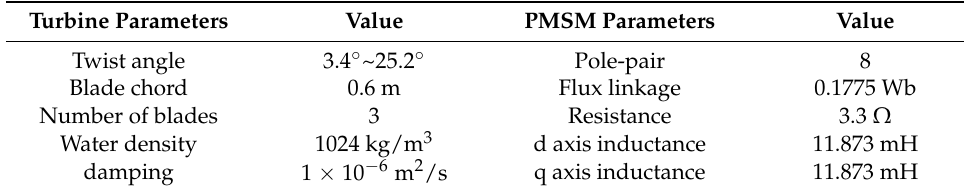
Figure 2. The structure of the experimental platform. Table 1. Specific parameters of MCT in the